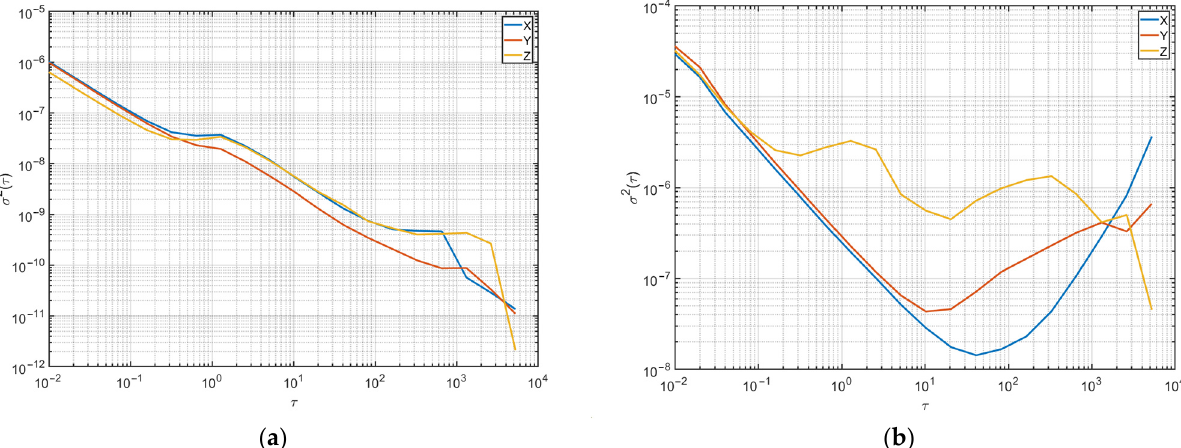
Figure 8. ( a ) Allan variance vs. time for angular velocity data obtained from a smartphone—no indication of a drift as the value of the variance is constantly decreasing. ( b ) Allan variance vs. time for acceleration data obtained from the same smartphone—a drift starts to occur after 40 s for the x -axis data, and after 10–20 s, it occurs for the y -axis data, as the variance starts to increase again after reaching its minimum value.